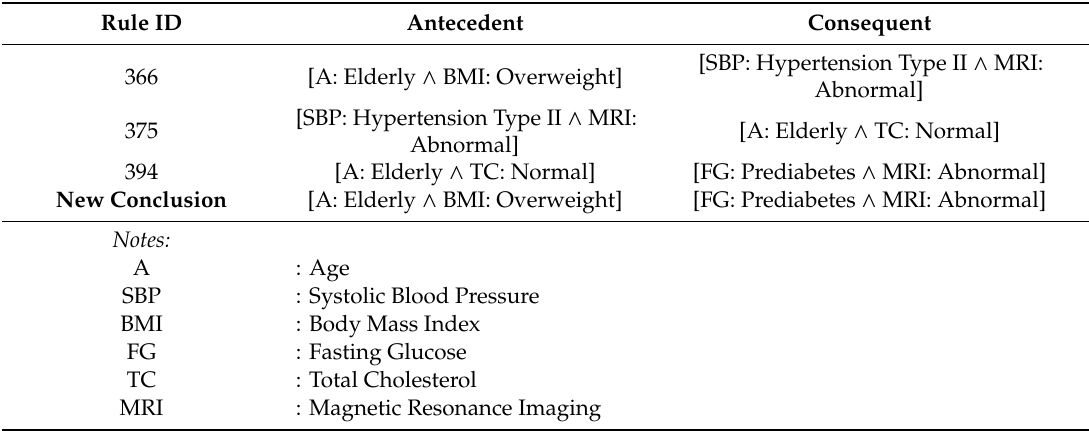
Table 10. Example of a conclusion obtained from rule inferencing: hypothetical